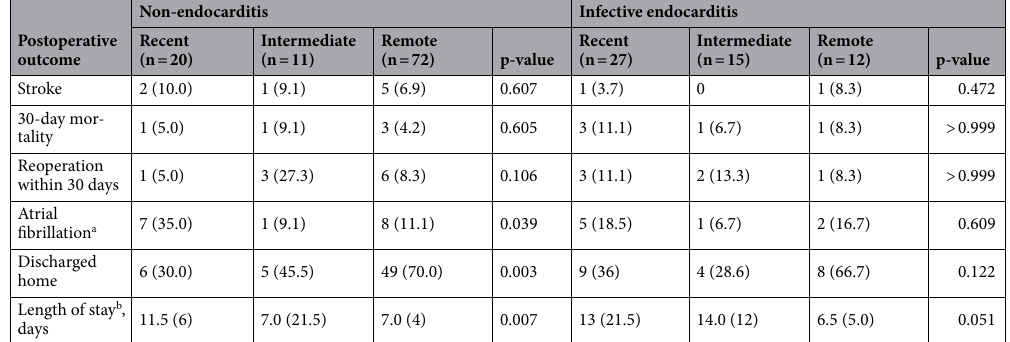
Table 3. Postoperative outcomes by endocarditis status and time cohort. Reoperation for any reason within 30 days. Length of stay represents time from surgery to discharge. Values are expressed as number (%) unless otherwise indicated. a Postoperative. b Median and interquartile